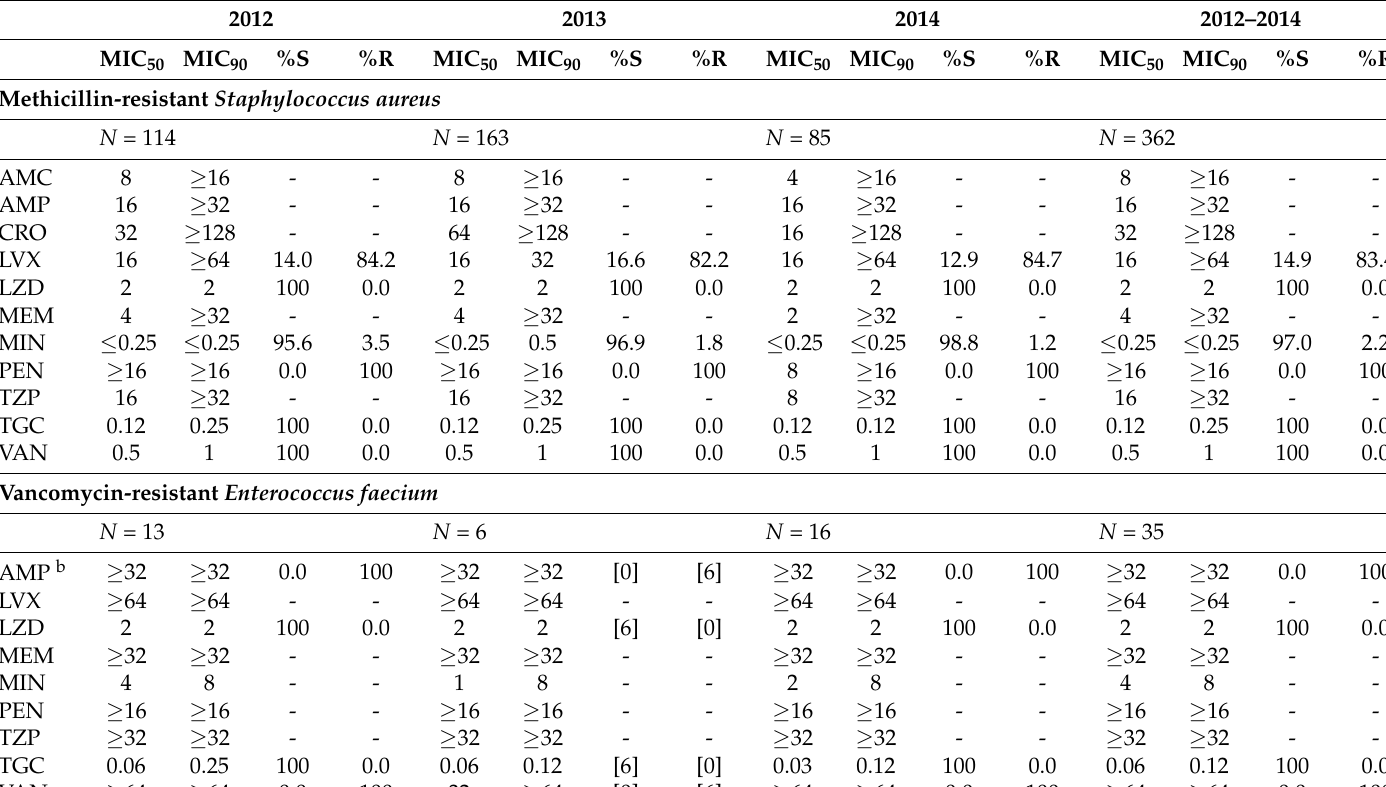
Table 5. Antimicrobial activity among resistant phenotypes of Gram-positive organisms collected from Italy between 2012 to 2014 a